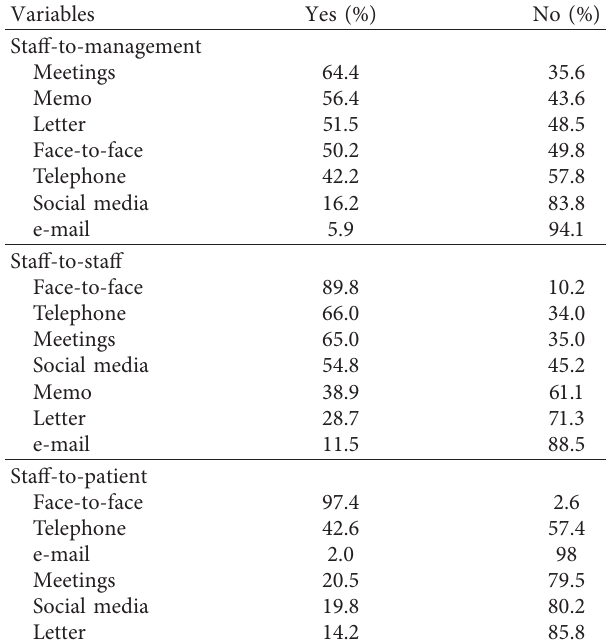
Table 2: Communication mediums as examined by health workers.